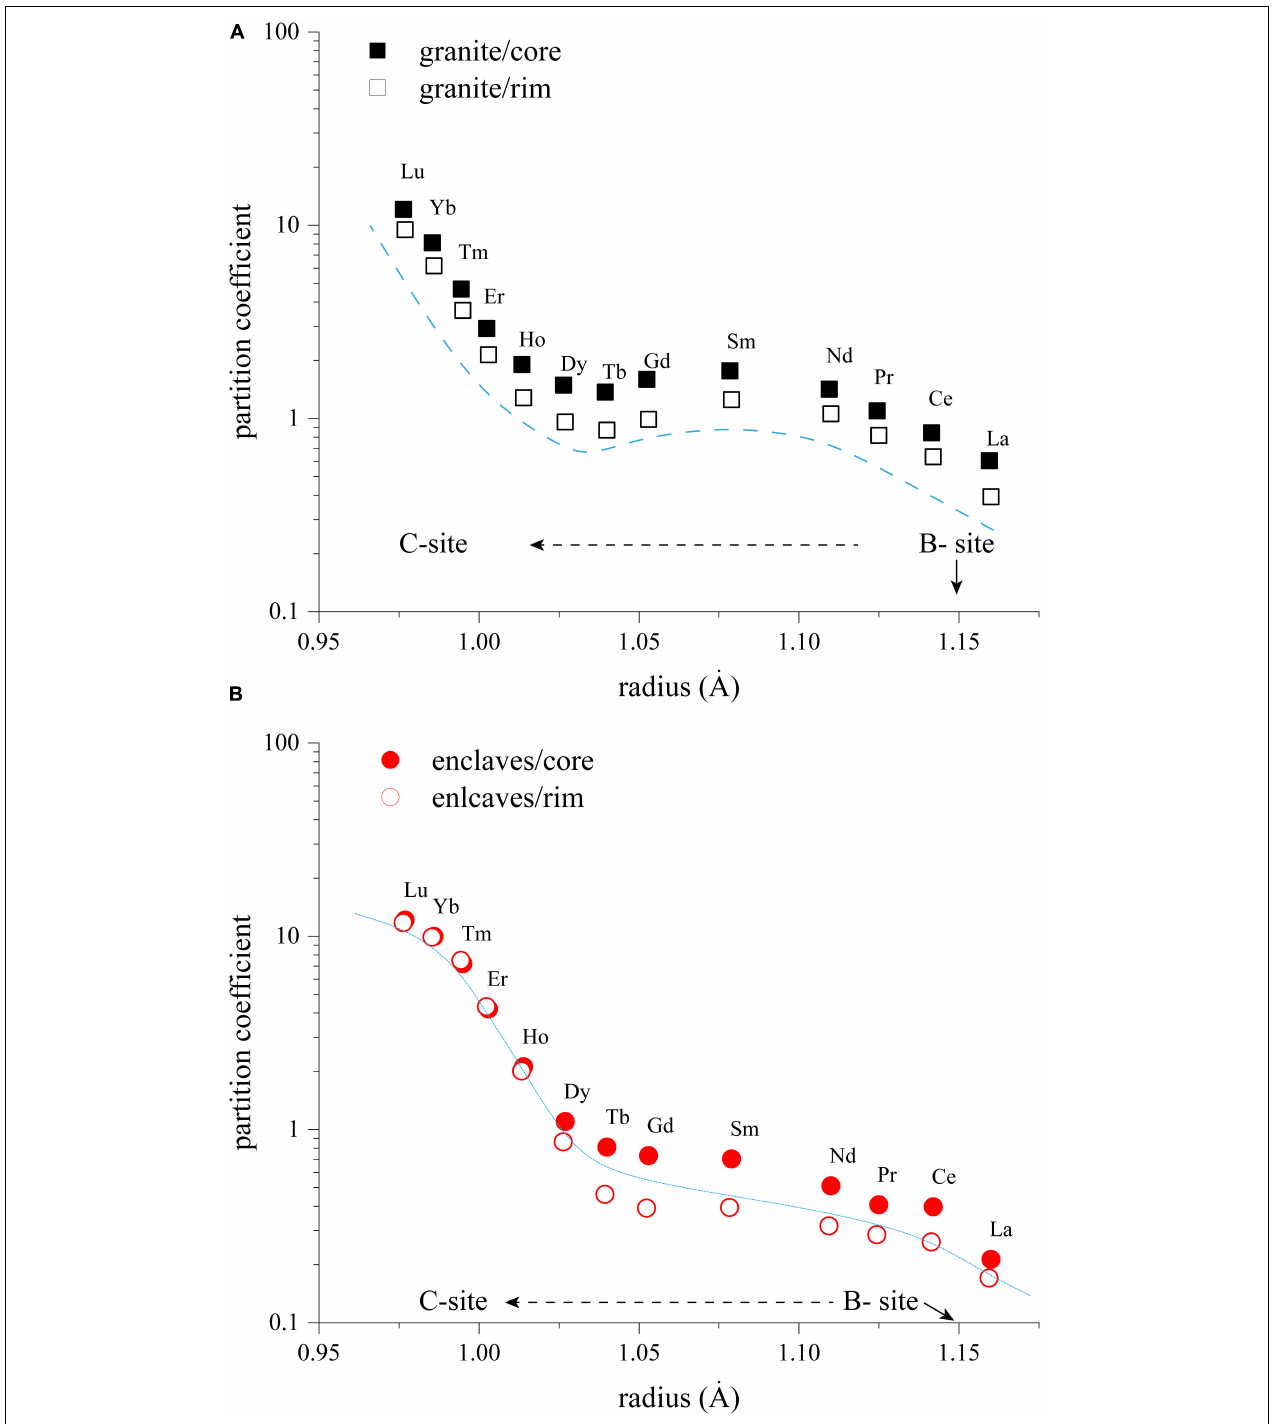
FIGURE 8 | Diagrams showing the relationship between ionic radii and apparent partition coefficient D amph − melt (average REE content of amphiboles/average REE content of the bulk rock) for amphiboles from the host granite (A) and from the enclaves (B) . Blue dash lines represent Lattice-Strain Theory fit through these data. Black dash lines reflect potential site preference of